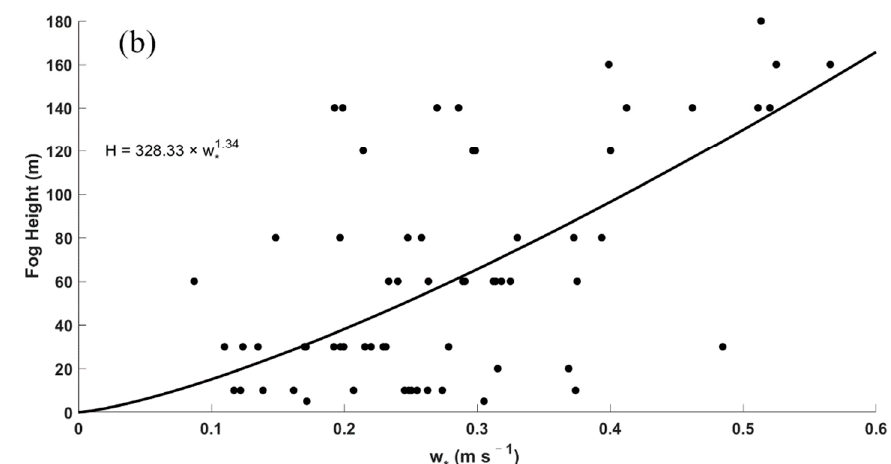
Figure 3. ( a ) Scatterplots of observations of fog thickness against the absolute values of sensible flux. The solid line denotes the relationship H = 29.49 ×| Hc | 0.45 . ( b ) Scatterplots of observations of fog thickness against the convective velocity scale. The solid line denotes the relationship H = 328.33 × w 1.34 ∗ .